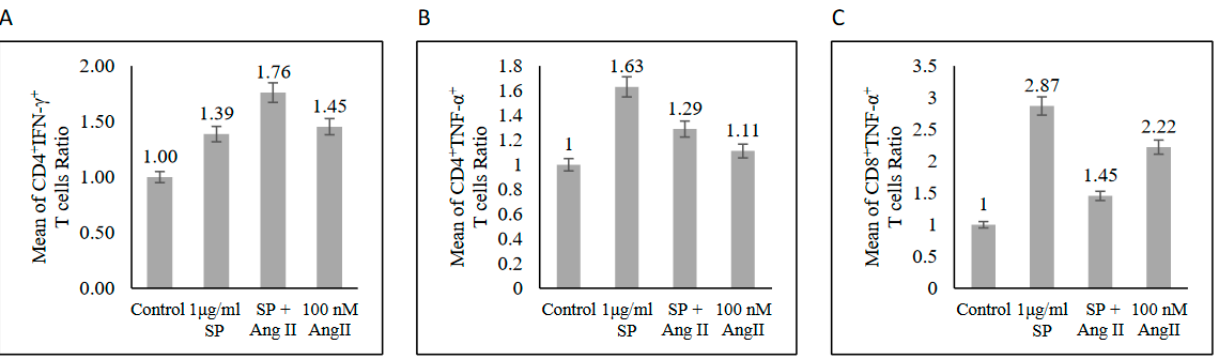
Figure 4. Ratios of CD4+ T-cells producing IFN- γ ( A ), TNF- α ( B ), and CD8+ T-cells ( C ) producing TNF- α in response to the SARS-CoV-2 peptide pool (SP), angiotensin II (Ang II), or both of SP and Ang II stimulation in PBMCs from recovered COVID-19 patients (n = 5). The mean of the T-cells ratios was measured as the percentage of T-cells producing cytokine in each group to the percentage of T-cells producing cytokine in the control group.